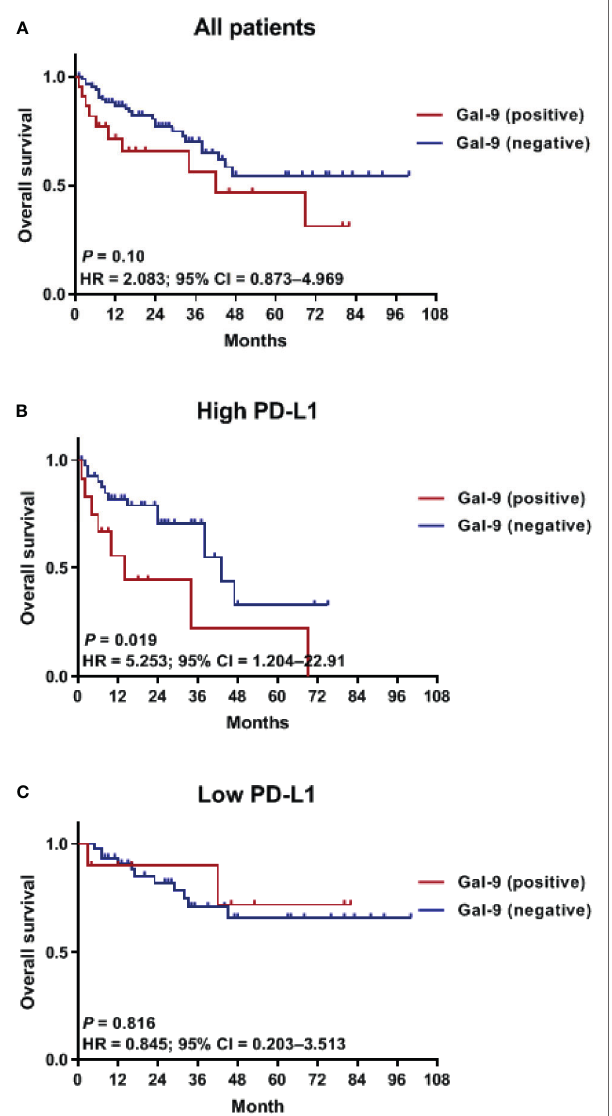
FIGURE 4 | Kaplan – Meier curves for OS in relation to Gal-9 and PD-L1 expression. OS curves in (A) all patients, (B) the high PD-L1 expression group, and (C) the low PD-L1 expression group. OS, overall